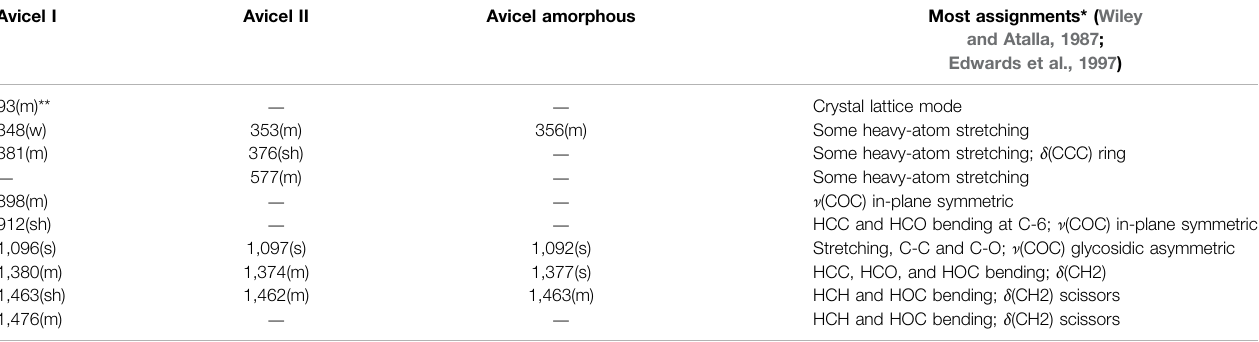
TABLE 1 | Selected Raman frequencies and their assignments (70 – 1,550 cm − 1 ) of cellulose I (Avicel I), cellulose II (Avicel II), and amorphous cellulose (Avicel amorphous). Avicel I